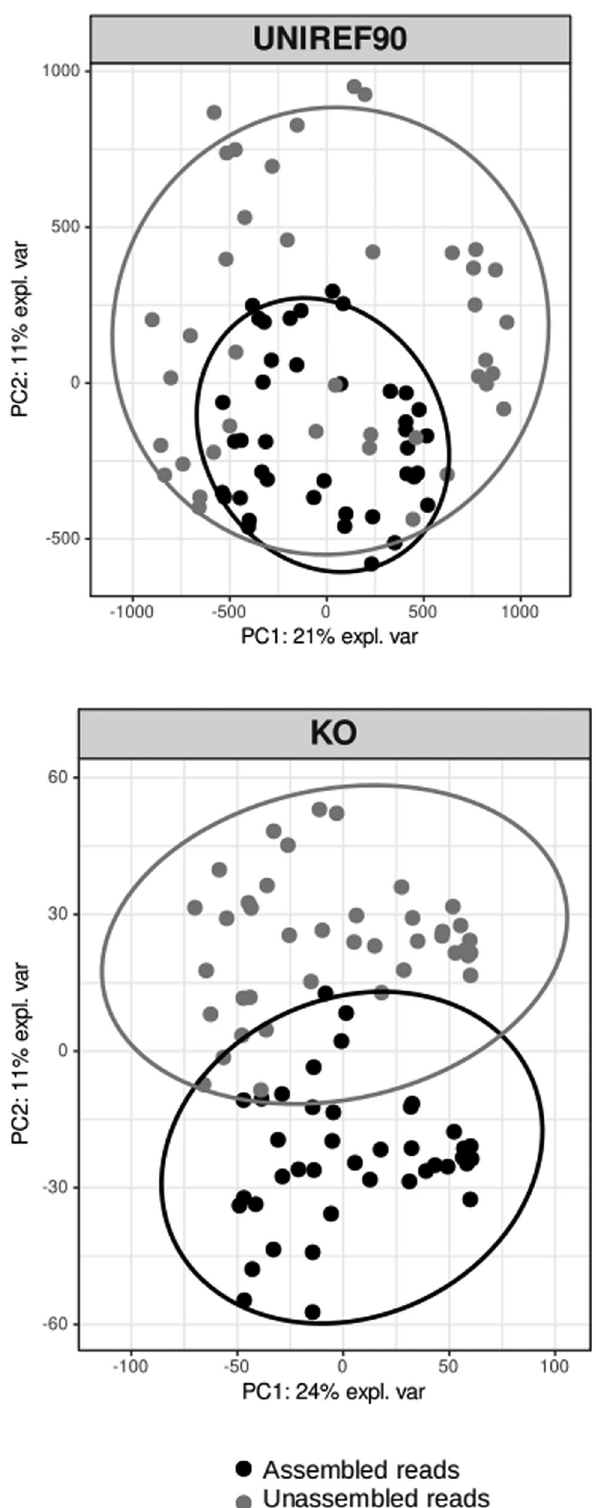
Fig. 5 Sparse Principal Component Analysis conducted of the read composition annotated against the UNIREF90 (top) and the KO databases (bottom). The ANOSIM statistics based on the Bray- Curtis similarity were R = 0.63 ( P < 0.01) for the UNIREF90 dataset and R = 0.90 ( P < 0.01) for KO